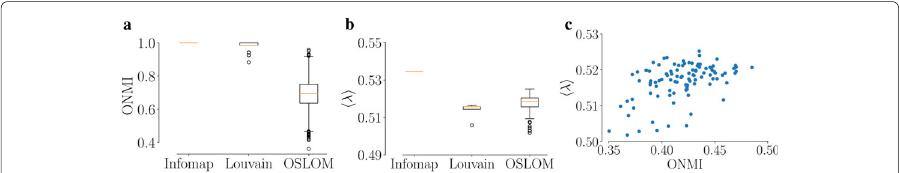
Fig. 12 Comparison between different community detection algorithms for the Enron email corpus case study. In ( a ), we show the box-plots of the distribution of the ONMI for each pair of outputs over 100 runs of the three community detection algorithms. The output of OSLOM seem to be highly unstable, confirming our preliminary observations. In ( b ), we plot the distribution of (cid:9) λ (cid:10) for the three algorithms. Infomap has the largest value of such a quantity. In ( c ), for each one of the 100 different outcomes of the OSLOM algorithm, we compare (cid:9) λ (cid:10) with the ONMI with the (unique) output of Infomap. The positive correlation that seems to be present supports our suggestion of using (cid:9) λ (cid:10) to evaluate the outcome of a community detection algorithm. In fact, the outputs that are closer to the stable community structure identified by Infomap have a higher value of (cid:9) λ